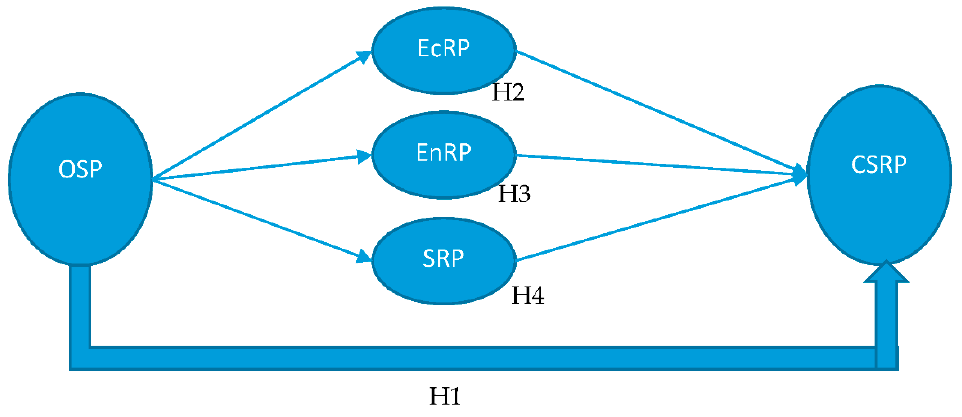
Figure 1. Conceptual framework.